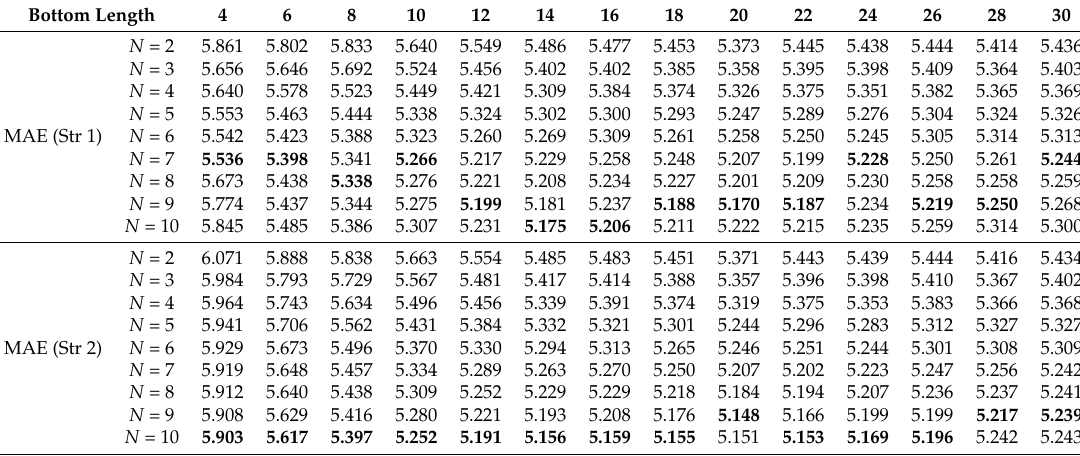
Table 8. The impacts of different values of N (2–10) on MAEs using the proposed SDM-LDL algorithms with Strategies 1 and 2 when age label distribution is generated as triangle (bottom lengths from 4 to 30; for every value of bottom length, the optimal MAEs are marked in